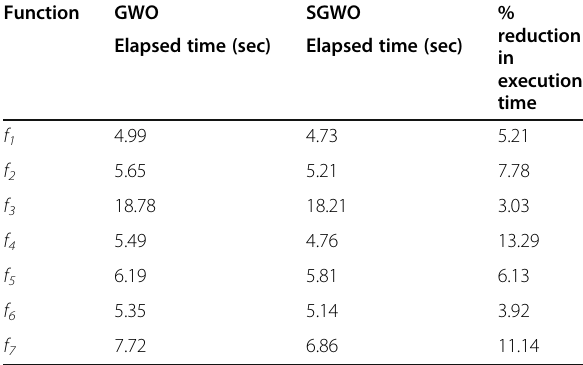
Table 4 Comparison of computational time between GWO and SGWO for unimodal functions Function